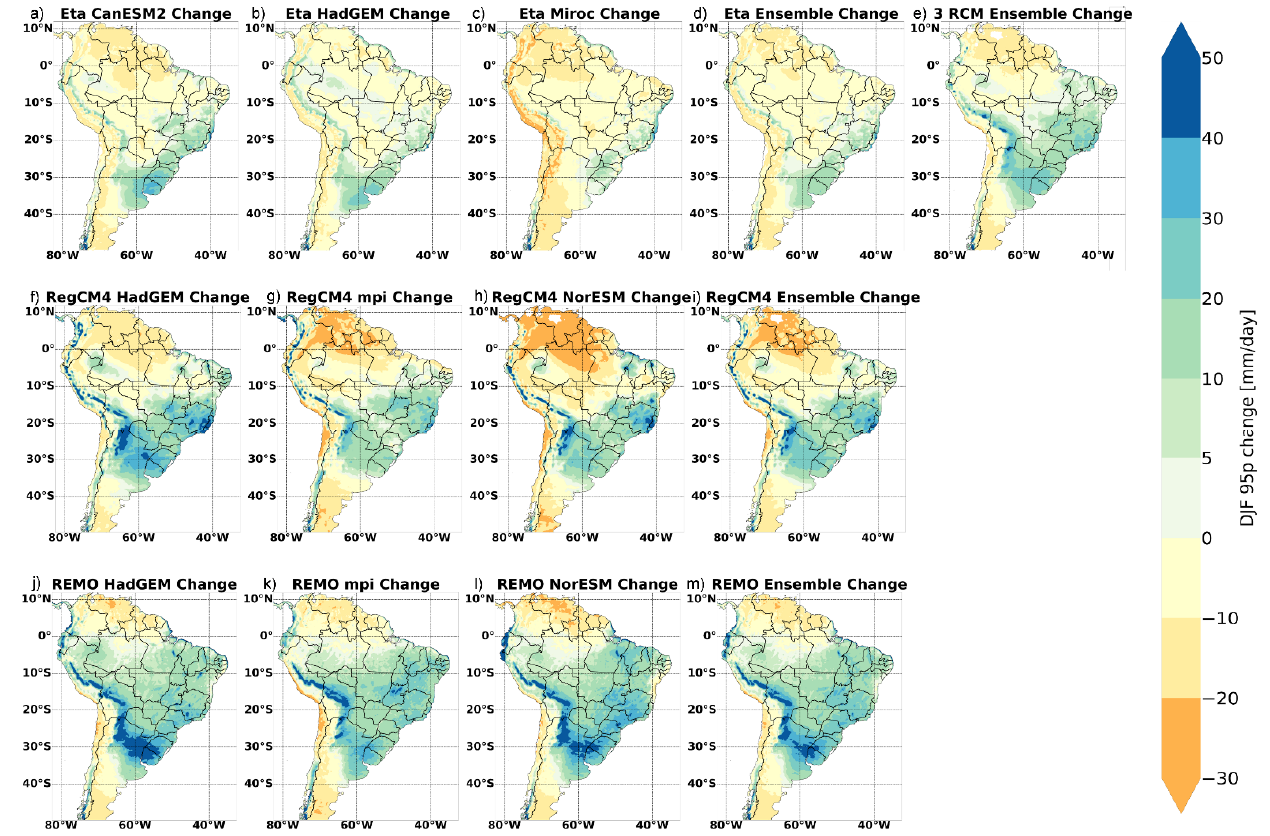
Figure 6. Changes projected to P95 (mm/day) during austral summer computed from each member of: ( a – d ) Eta, ( f – i ) RegCM, and ( j – m ) REMO individual ensembles, and ( e ) 3RCMs ensemble. Changes in the percentile of 95% are obtained with the difference obtained in the 2015–2099 and 1995–2014 periods.